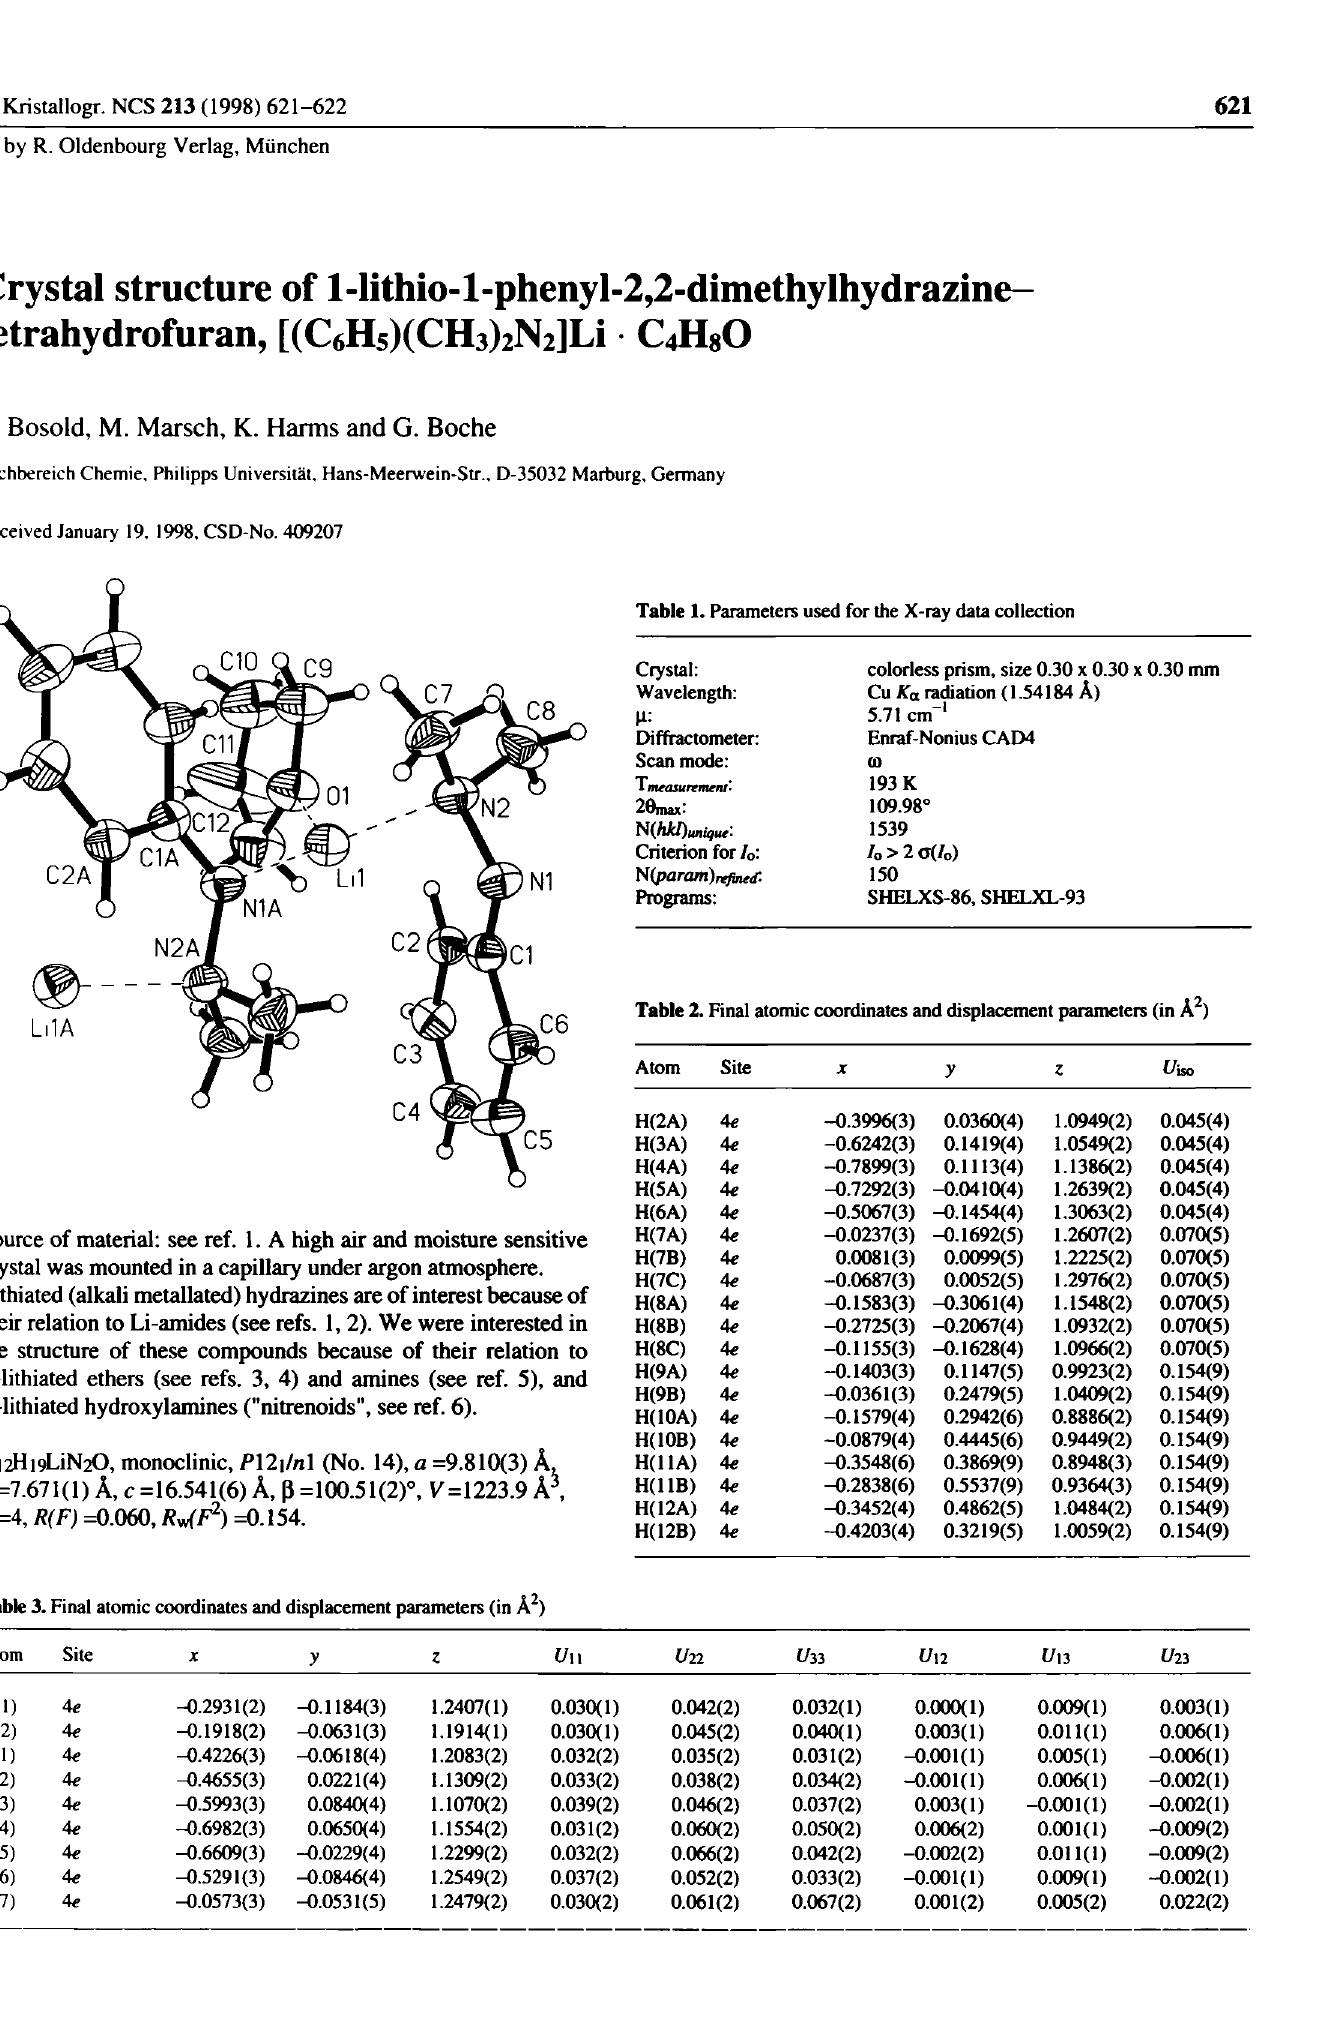
Table 3. Final atomic coordinates and displacement parameters (in Â^)